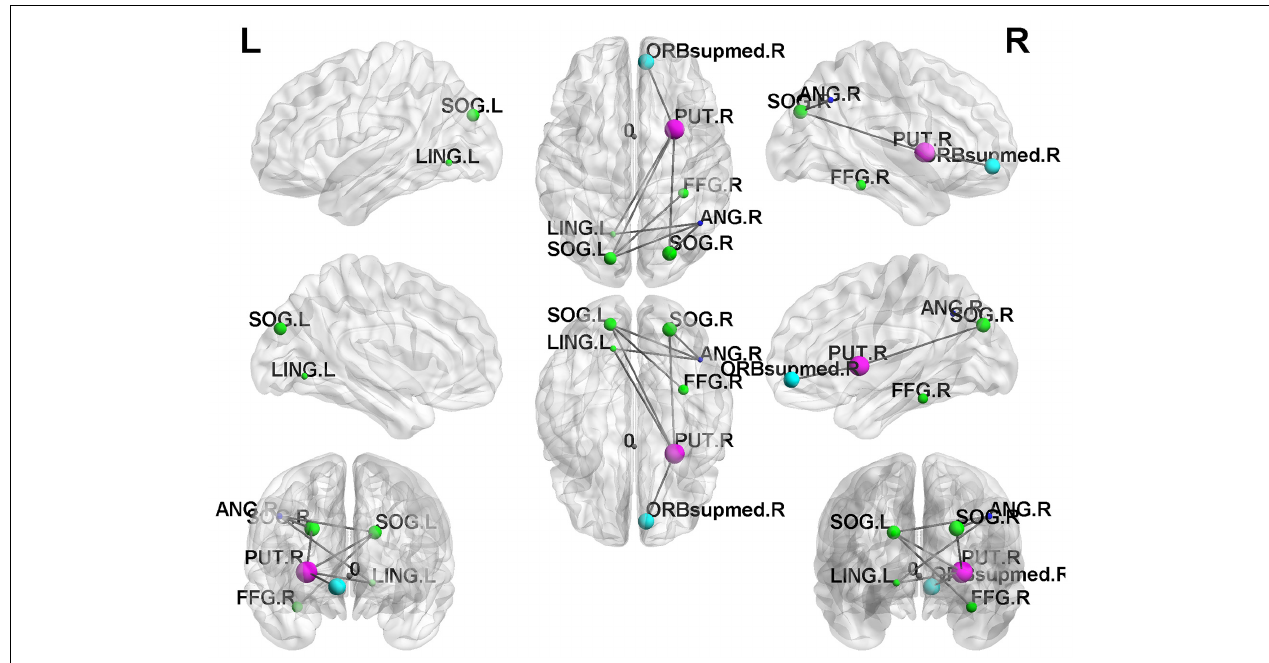
FIGURE 4 | Network-based statistical (NBS) results. The SI + group demonstrated significantly reduced subnetwork connections in the frontal lobe compared to the HC group ( p < 0.05).